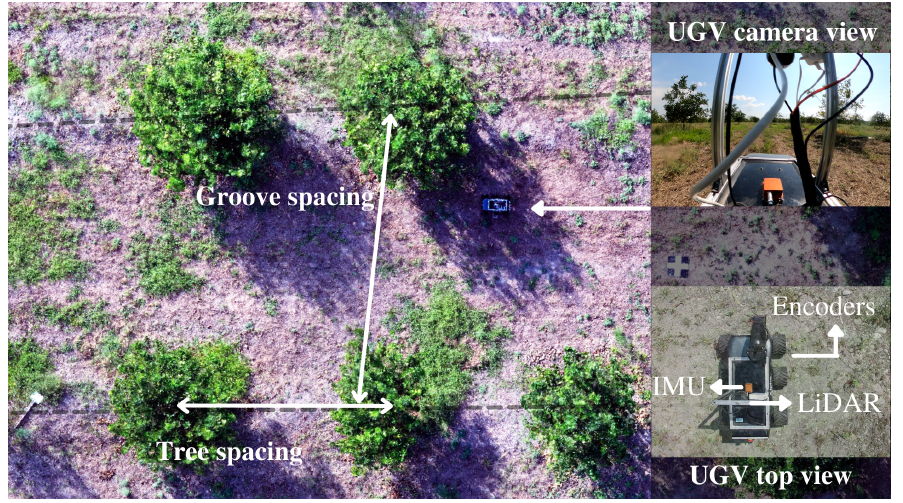
Figure 8. The mobile 3D LiDAR mapping system into the citrus